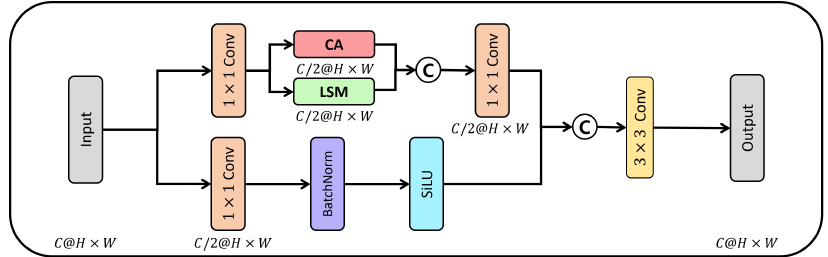
Figure 5. Proposed dual-path lightweight module structure. BatchNorm: batch normalization; (C): concatenation; Conv: convolution; CA: channel attention; H × W: (H: height, W: width) input feature map size; LSM: lightweight spatial model; SiLU: sigmoid linear